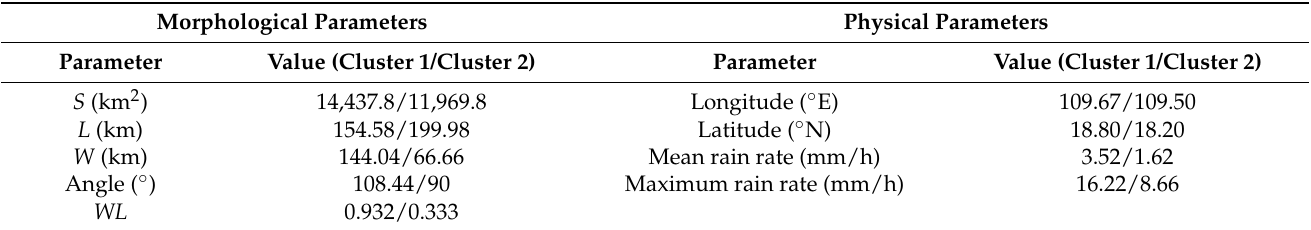
Figure 2. Rain intensity of the two rain clusters (units: mm/h). The formation times were ( a ) 16:00 on 27 August 2006 and ( b ) 12:30 on 12 August 2000 (Beijing Time, UTC+8). The blue rectangle is the MBR; the red solid line is the outline of the rain cluster; the star is the center of the bounding rectangle; and the black solid line is the coastline of Hainan Island. Table 2. Morphological and physical parameters of the two rain clusters shown in Figure